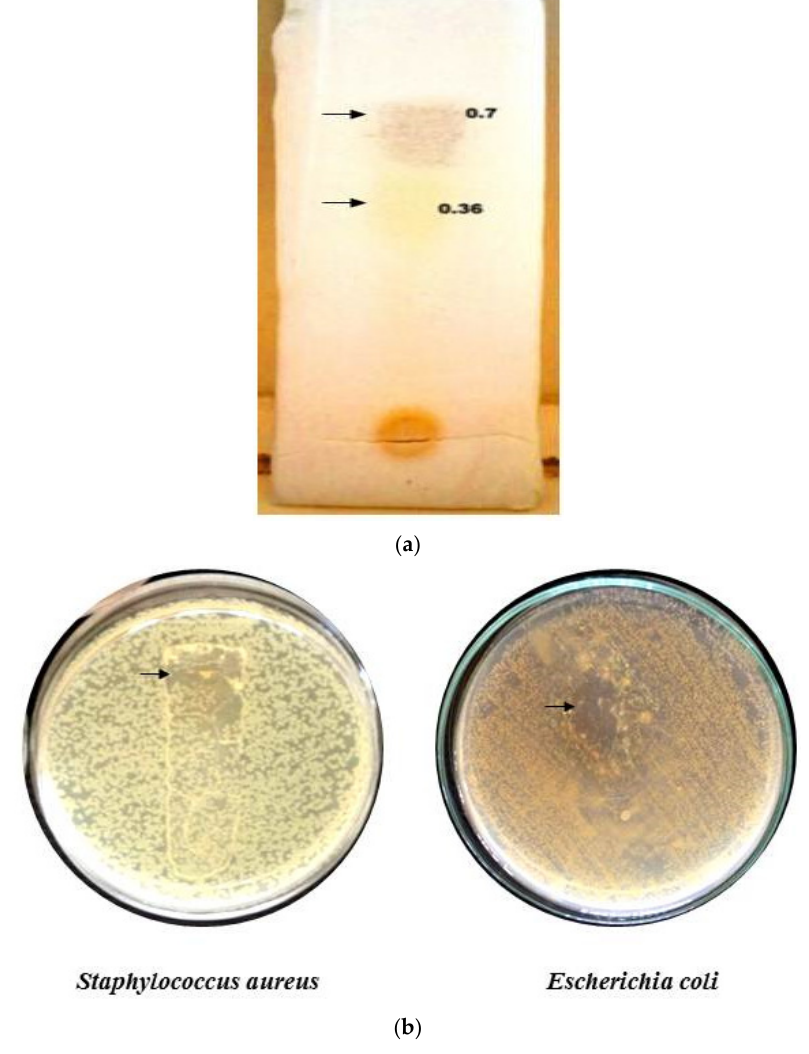
Figure 5. TLC of F3 column fraction ( a ) and Bioautography ( b ).